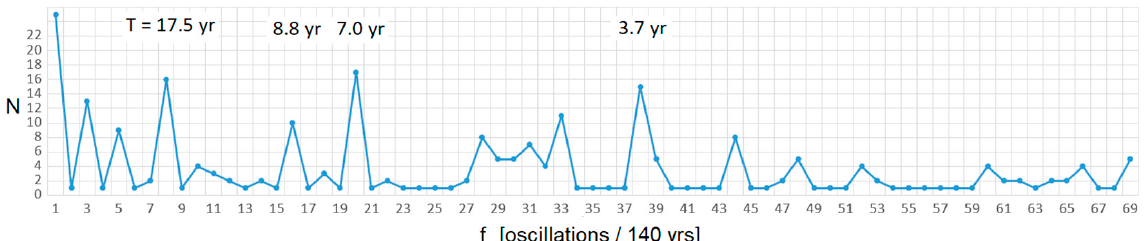
Figure 7. Number n of stations with highest amplitude and close phases at the same time (see Figure 6 and description in the text). Ignoring f = 1 (trend, and also the low f = 3), three n values are evidently the highest. The fourth (f = 16) is accepted because it is a harmonic of f = 8 (f = 33 is not such a case).